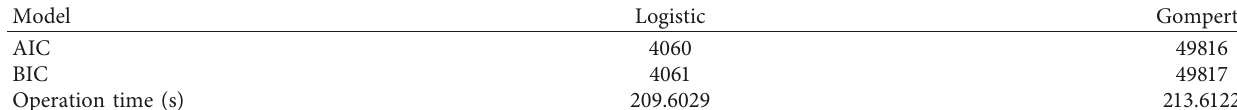
Table 9: AIC, BIC, and operation time of two models.